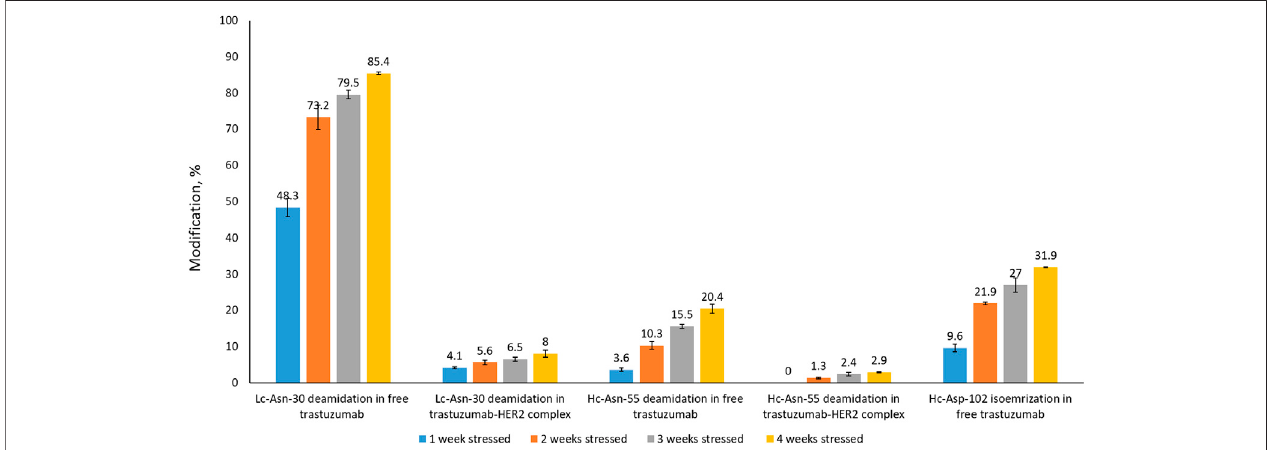
FIGURE 4 | Peptide mapping results of trastuzumab stressed free and in complex with HER2 for 1, 2, 3, or 4 weeks. Isomerization of Hc-Asp-102 was not detected in the trastuzumab – HER2 complex. Numbers given here are an average of two measurements.